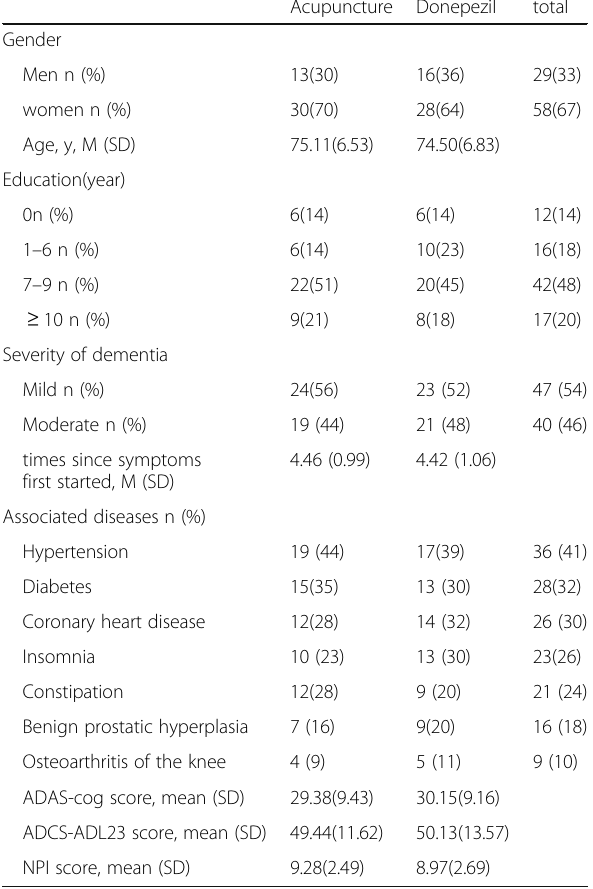
Table 1 Baseline characteristics of study participants Acupuncture Donepezil total